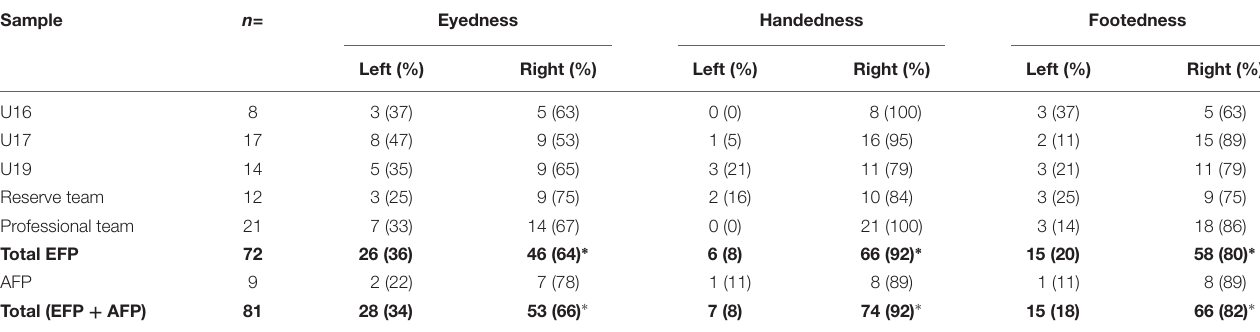
Data are means ( ± SD). EFP, elite football players; AFP, amateur football players. ∗ Significantly different between Left and Right, p < 0.05.